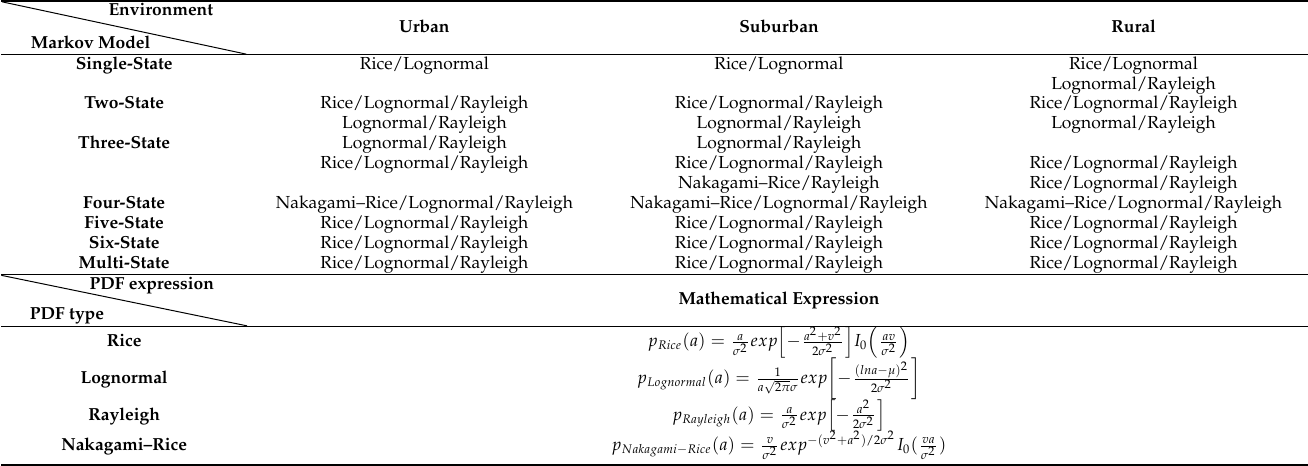
Table 6. Urban, suburban, and rural environment statistic